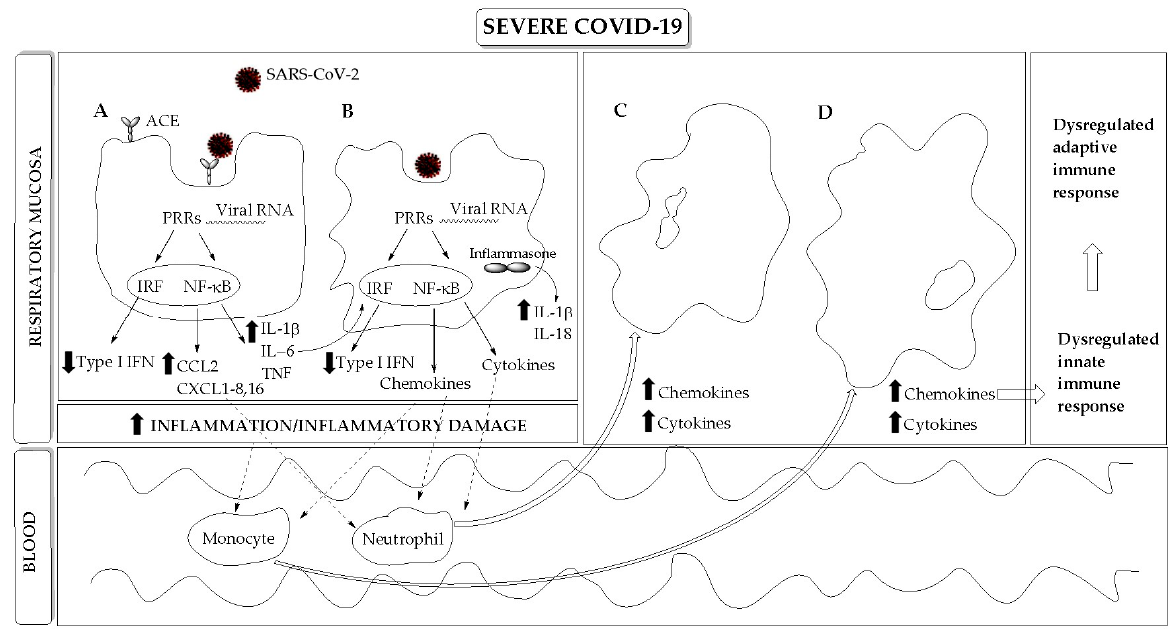
Figure 1. Immune response dysregulation induced by SARS-CoV-2 in severe COVID-19. Legend: A=Respiratory epithelial cells; B=Resident macrophages; C=Blood-recruited neutrophils; D=Monocyte-derived macrophages. Abbreviations: ACE=Angiotensin Converting Enzyme; PRRs=Pattern Recognition Receptors; NF- κ B=Nuclear Factor- κ B; IRF=Interferon Regulatory Factor; IFN=Interferon; IL=Interleukin; TNF=Tumor Necrosis Factor; CCL=C-C motif Chemokine Ligand; CXCL=C-X-C motif Chemokine Ligand.